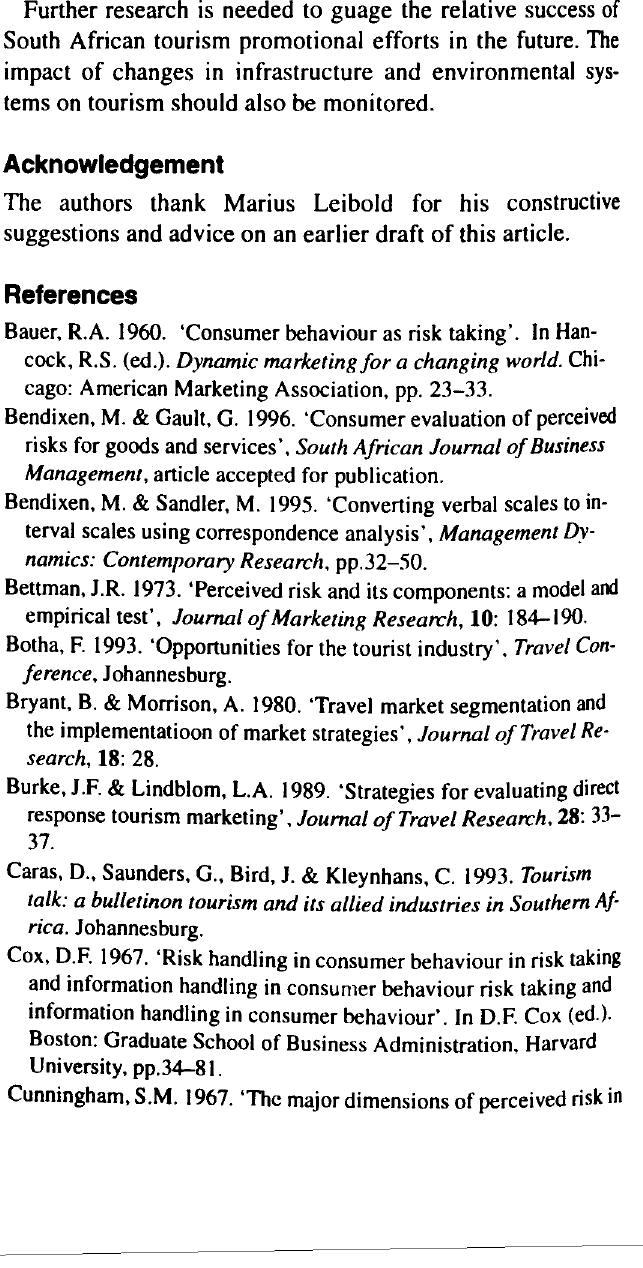
Figure 2 Marketing focus